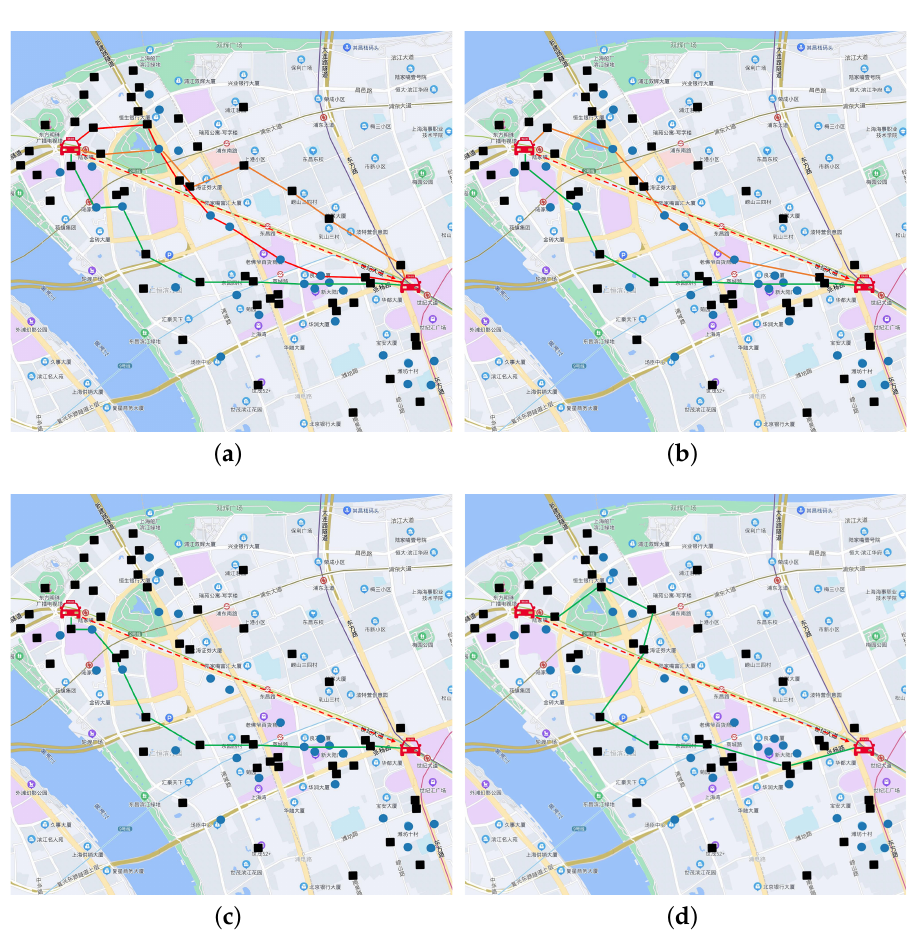
Figure 4. Service migration path in VEC environment (black squares indicate base stations, blue dots indicate network routers, dotted lines indicate vehicle movement directions, and solid lines indicate task migration paths.) ( a ) DRPS&DRPS/F; ( b ) PLP; ( c ) Greedy-SP; ( d )